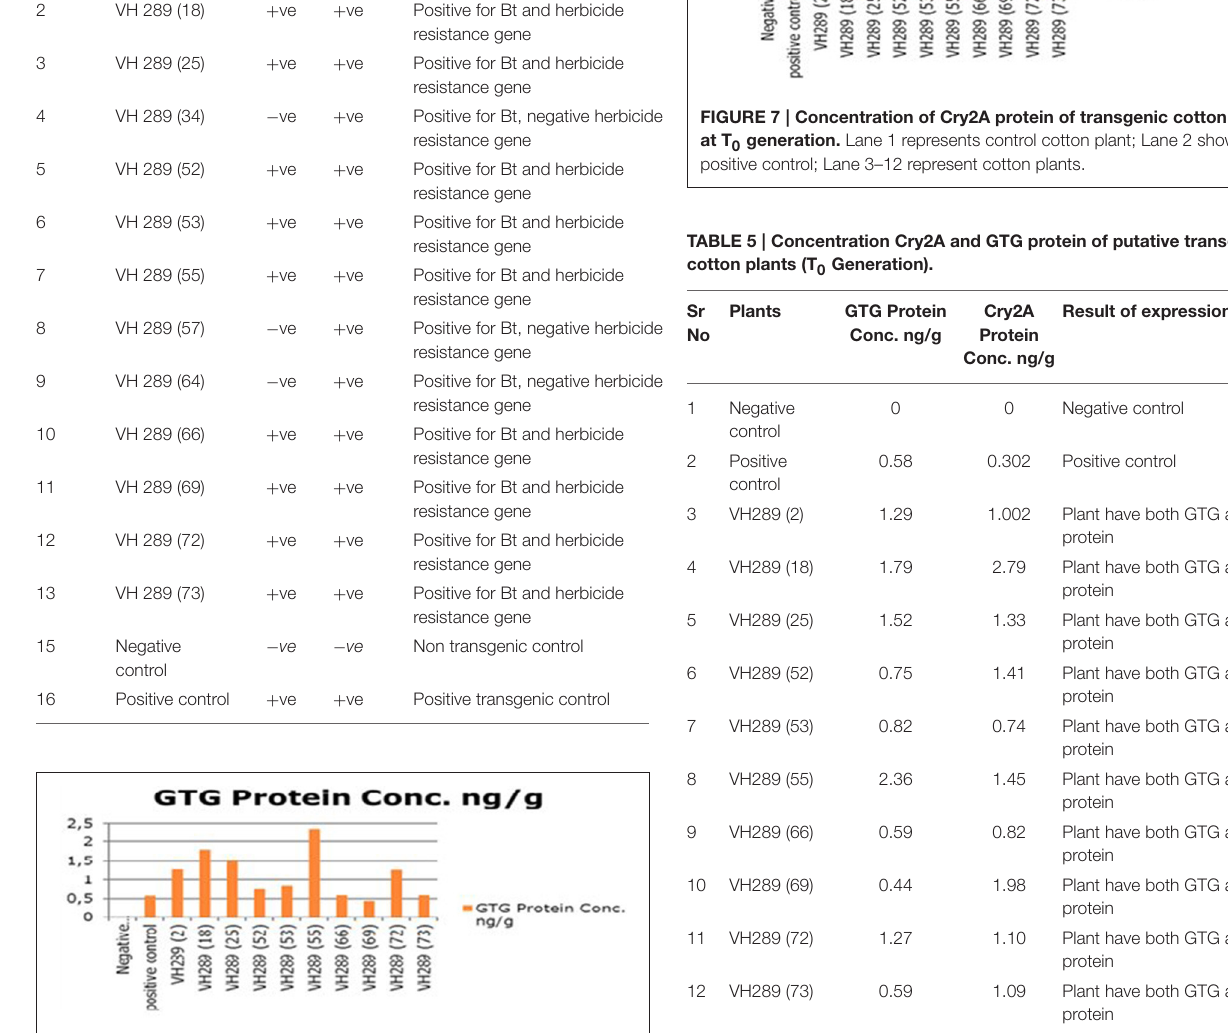
of the GTGene per g of fresh leaves was obtained as shown in